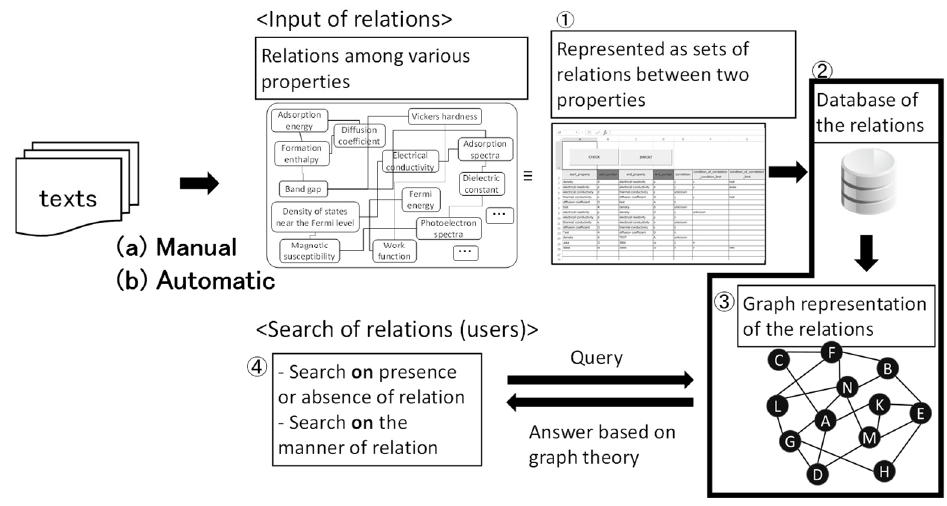
Figure 7. Schematic structure of the proposed system, which enables searches for relationships among material properties.